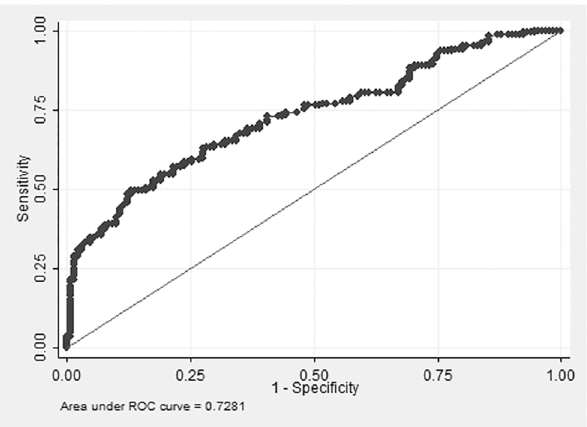
Fig 2. The receiver operating characteristic (ROC) curve of serum ANGPTL2 levels for the identification of patients with heart failure.